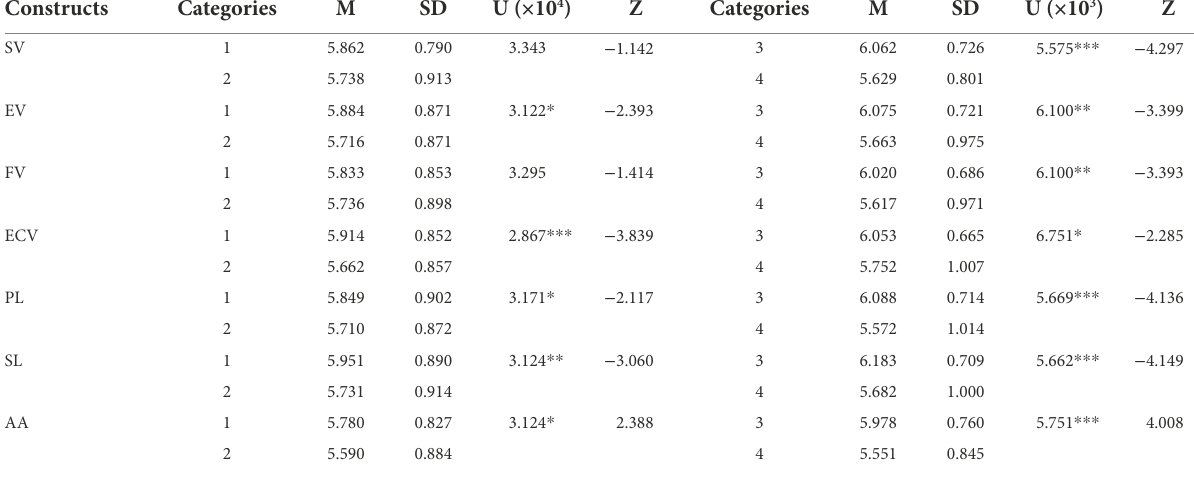
TABLE 13 Effects of whether convenience stores participated in community group buying and whether selecting them as self-pickup points on different variables.